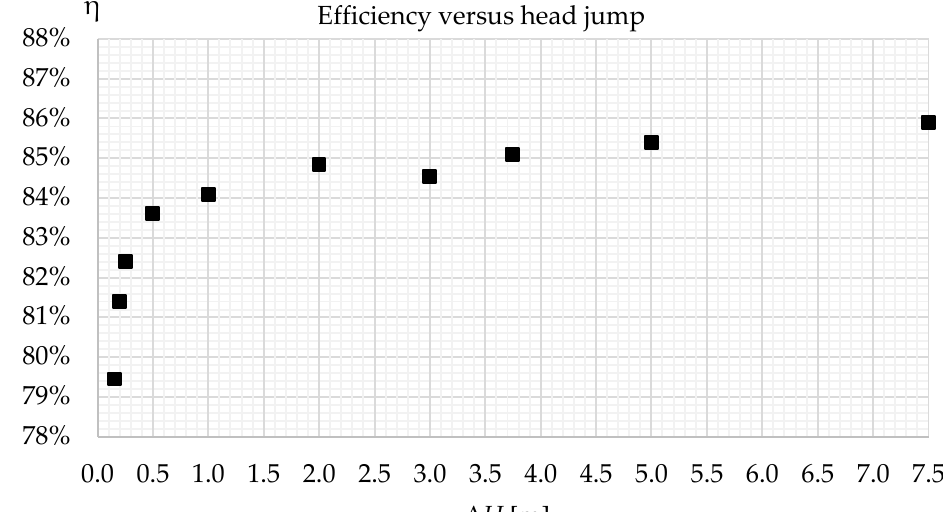
Figure 3. Efficiencies versus head jumps solved using 2D CFD analysis.